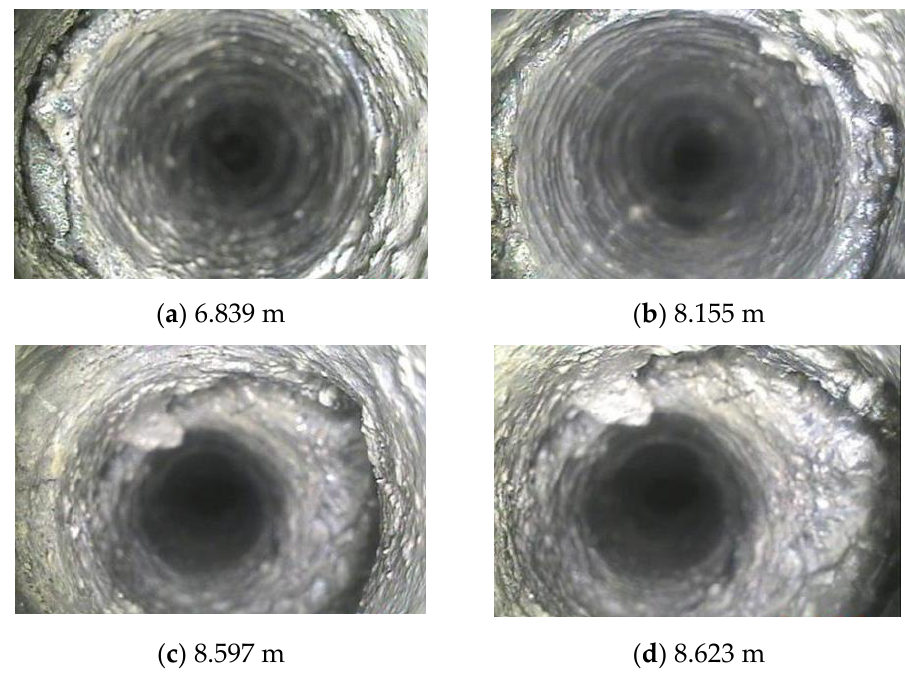
Figure 8. Borehole views at the roof of the 360,805 conveyor roadway. The displacement of surrounding rock in the 360,803 airway was continuously moni- tored using a roof separation instrument. Figure 9 shows the roof separation and deforma- tion characteristics of surrounding rock in the 360,803 airway.